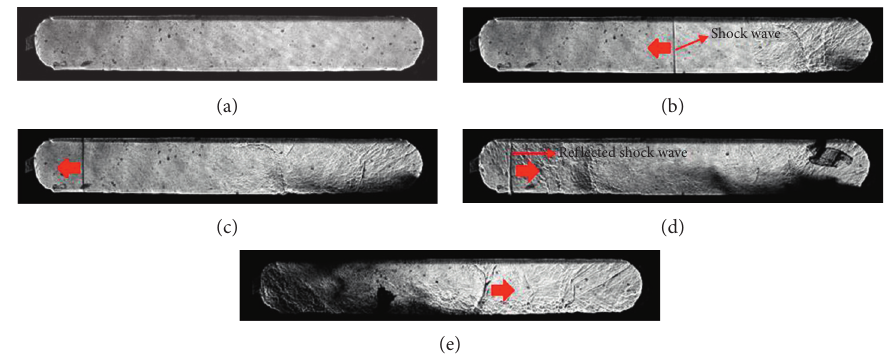
Figure 7: Shock wave propagation from experimental visualization.